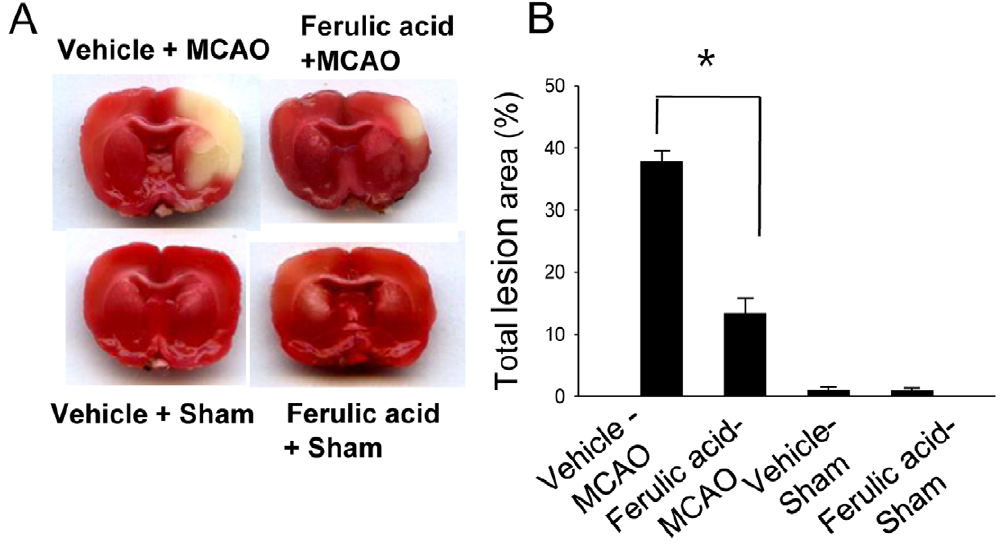
Figure 1. The neuroprotective effect of ferulic acid in focal cerebral ischemia. Representative photos of TTC stain in the cerebral cortices of vehicle + sham, ferulic acid + sham, vehicle + middle cerebral artery occlusion (MCAO), ferulic acid + MCAO animals. Animals were treated with vehicle or ferulic acid prior to MCAO. Brain sections were stained by TTC (A). The ischemic area remained white, while the intact area was stained red. The percentage of ischemic lesion area was calculated by the ratio of the infarction area to the whole slice area (B). Data are means 6 S.E.M. * P ,